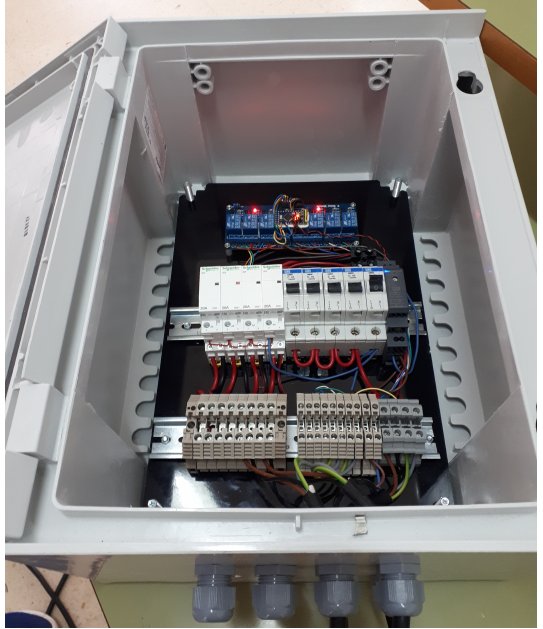
Figure 5. UHU-MUX multiplexer developed at the Universidad de Huelva.